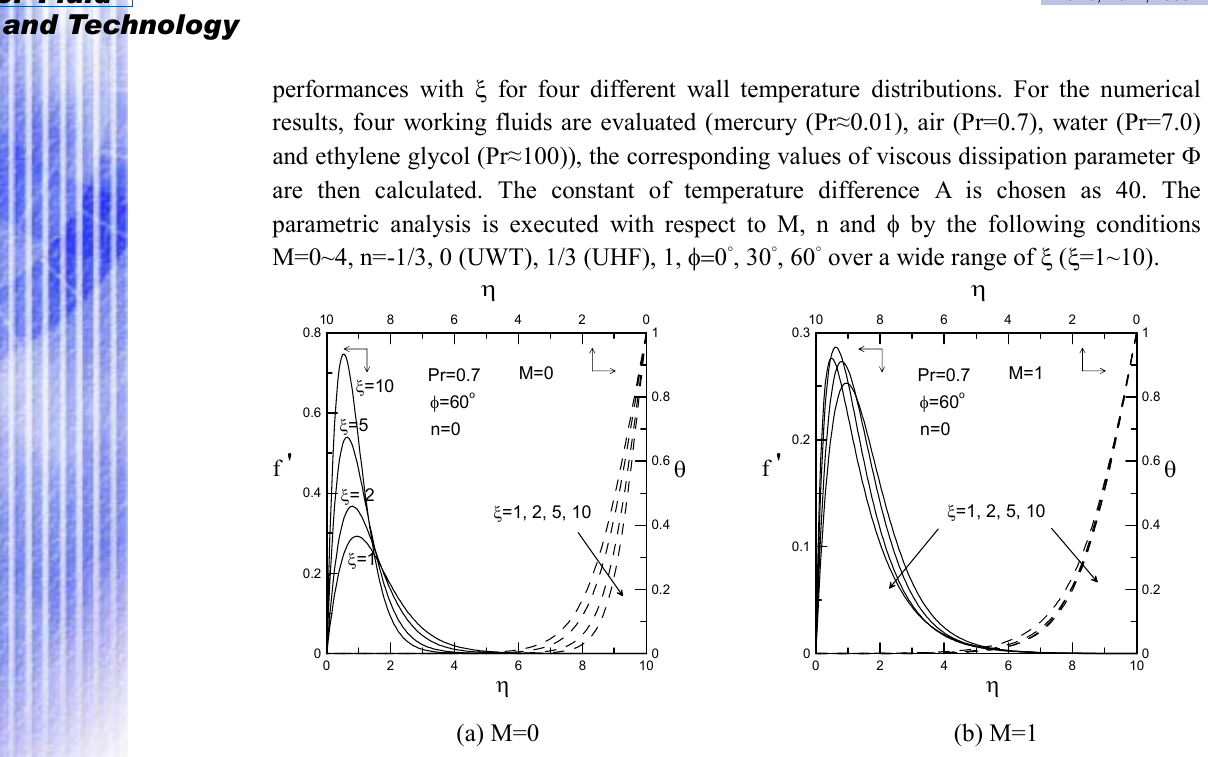
Figure 2 The velocity and temperature profiles across the boundary layer for various ξ with Pr=0.7, n=0, φ =60°, and (a)M=0, (b)M=1.